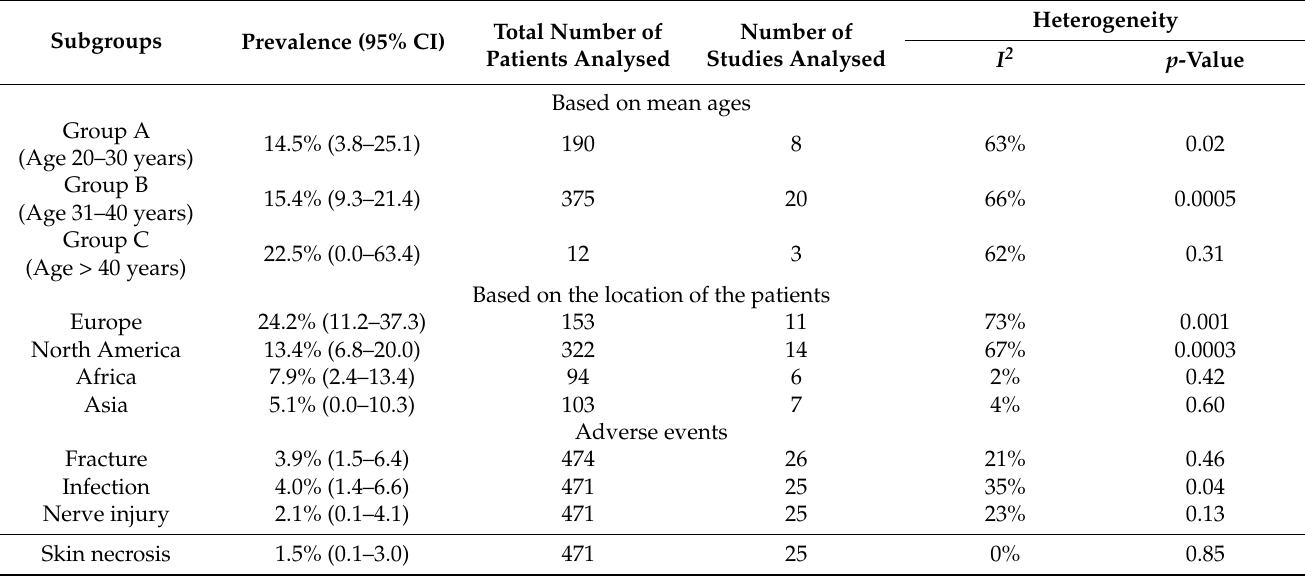
Table 2. Subgroup analyses estimating the prevalence of local recurrence in different age groups and locations and the prevalence of adverse events followed by cryosurgery.